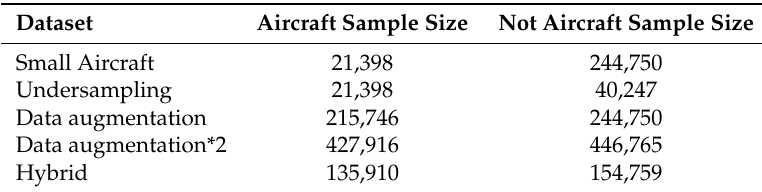
Table 1. Sample size for the ‘aircraft’ and ‘not aircraft’ classes, defined as the number of feature vectors extracted from the audio waveforms for each dataset.